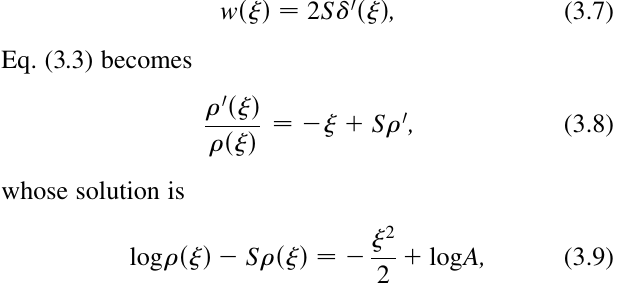
(cid:6) 0 : 085 , and N s